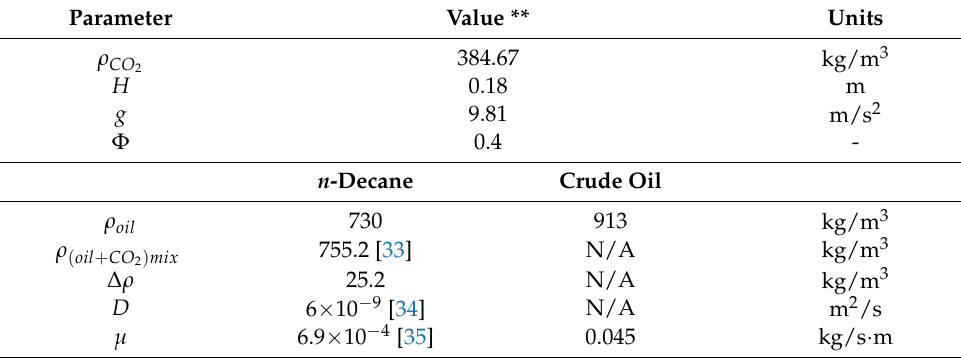
Table 3. Parameters for Ra number